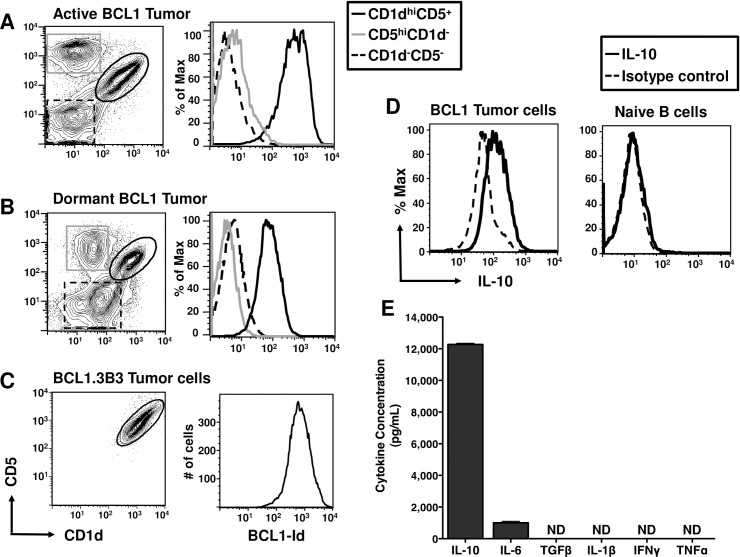
BCL1 tumor cells express the characteristics of B10 Bregs.Examination of a B10 Breg phenotype performed on spleen cells from mice injected with (A) BCL1 tumor cells only, (B) pre-immunized with BCL1-Id+ IgM and challenged with BCL1 tumor cells, and (C) in vitro-adapted BCL1 tumor cells. The analysis shows 3 distinct subsets, of which the B10 Breg phenotype (CD1dhiCD5+) is unique to the BCL1-Id+ tumor cells. Representative plots of at least 3 or more independent experiments are shown. (D) Intracellular cytokine staining of spleen cells from mice challenged with BCL1 tumor cells (solid line) or naïve mice (dashed line). Histogram plots are representative of 3 independent experiments. (E) The cytokine profile of supernatants from BCL1.3B3 tumor cells following a 72 h culture period as determined by ELISA. Total values are shown as mean ± SEM from 2–3 experiments. ND, below detection limits.